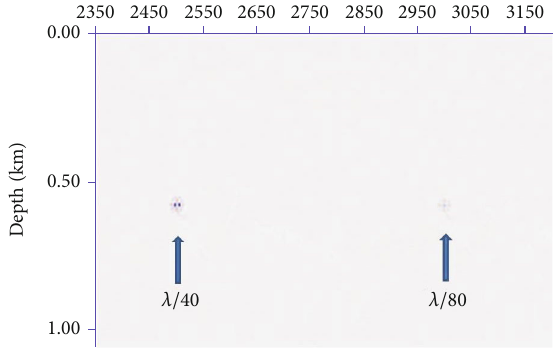
Figure 6: The local section of the small-scale lens model.